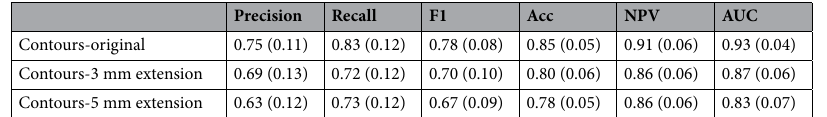
Table 4. The distinction of NTM lymphadenitis from reactive and proliferative lymphadenopathy. Reported results indicate the mean and standard deviation (in brackets) across 100 runs.